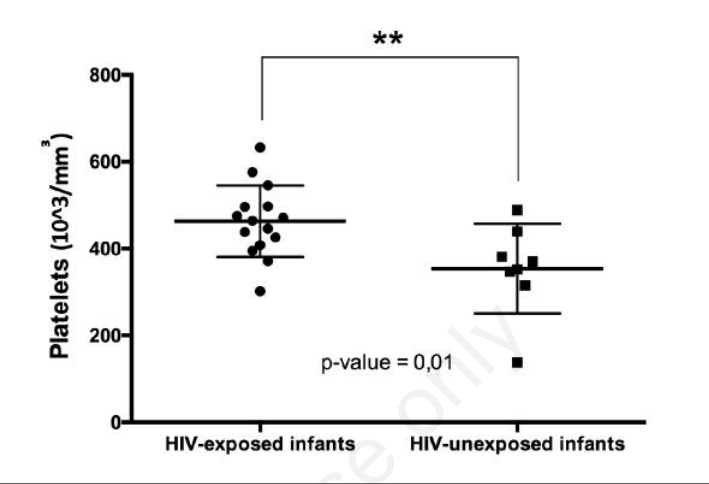
Figure 1. Platelets count in HIV-exposed uninfected (HEU) and HIV unexposed (HU) infants. The platelets count was significantly higher in HEU infants than HU infants (P=0.01). The observed difference was physiologically and clinically